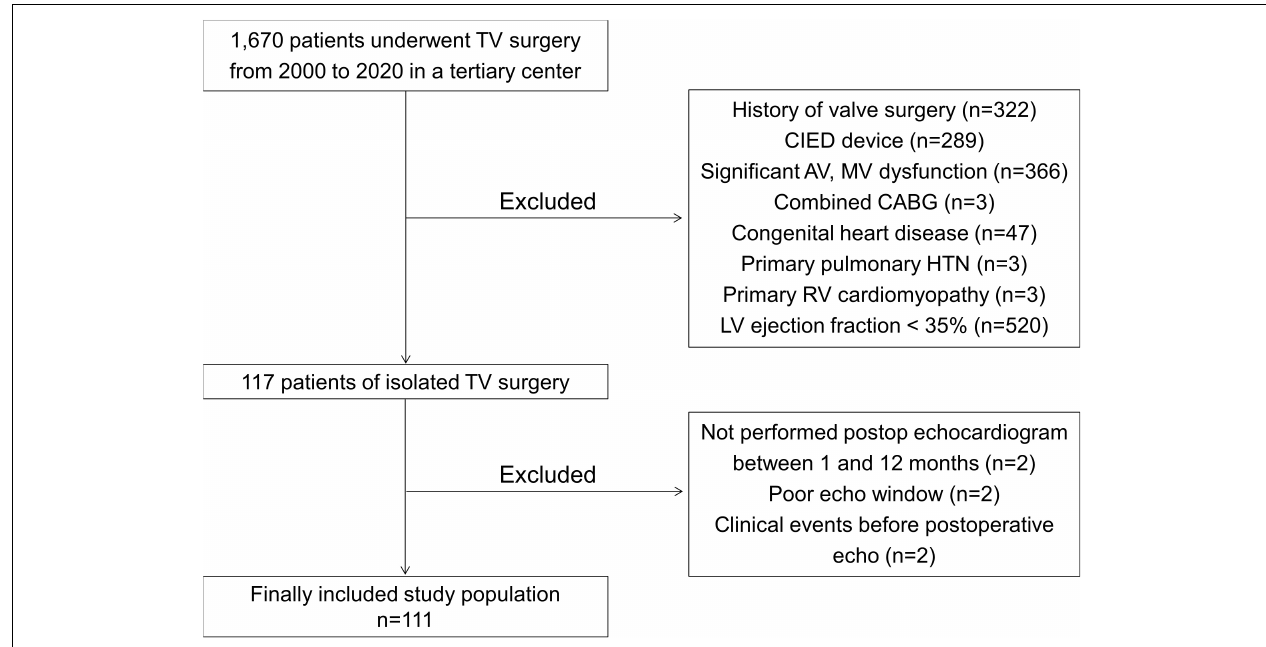
FIGURE 1 | A flowchart of this study. TV, tricuspid valve; CIED, cardiovascular implantable electronic devices; AV, aortic valve; MV, mitral valve; CABG, coronary artery bypass graft; HTN, hypertension; RV, right ventricle; LV, left